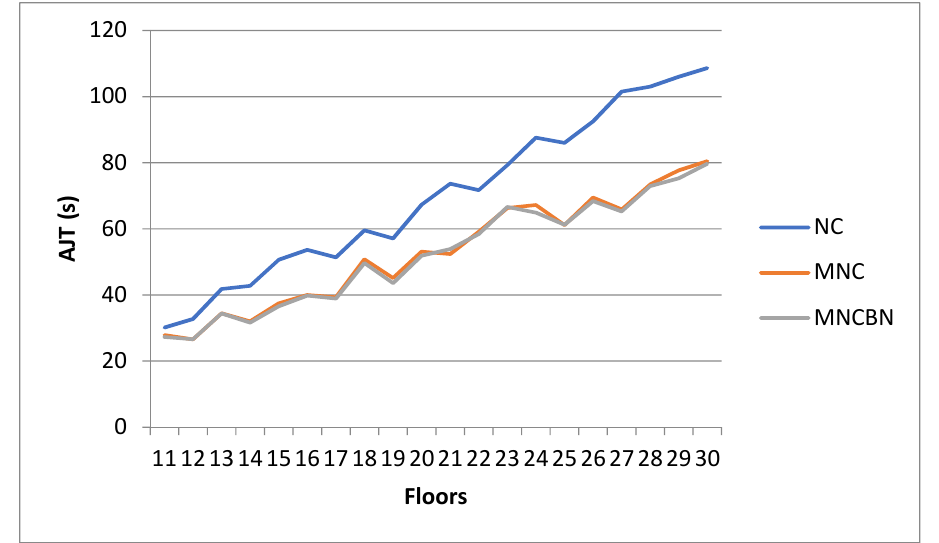
Figure 12. Dependence of AJT on the building height for the random interfloor traffic pattern.